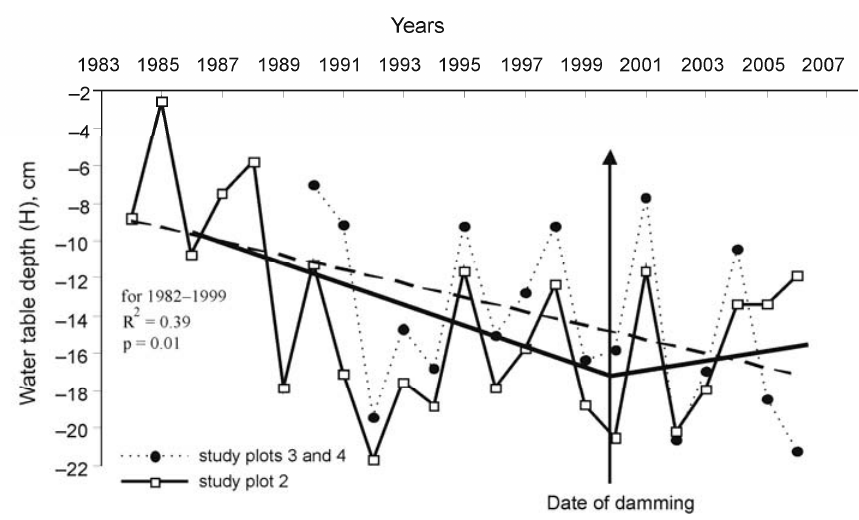
Fig. 3. Variation in water table depth during the growth period (May to October) in the extensively drained and dammed site (study plot 2, the line marked with open squares) and in the naturally developing part (control study plots 3 and 4, marked with filled cycles) during 1984–2006